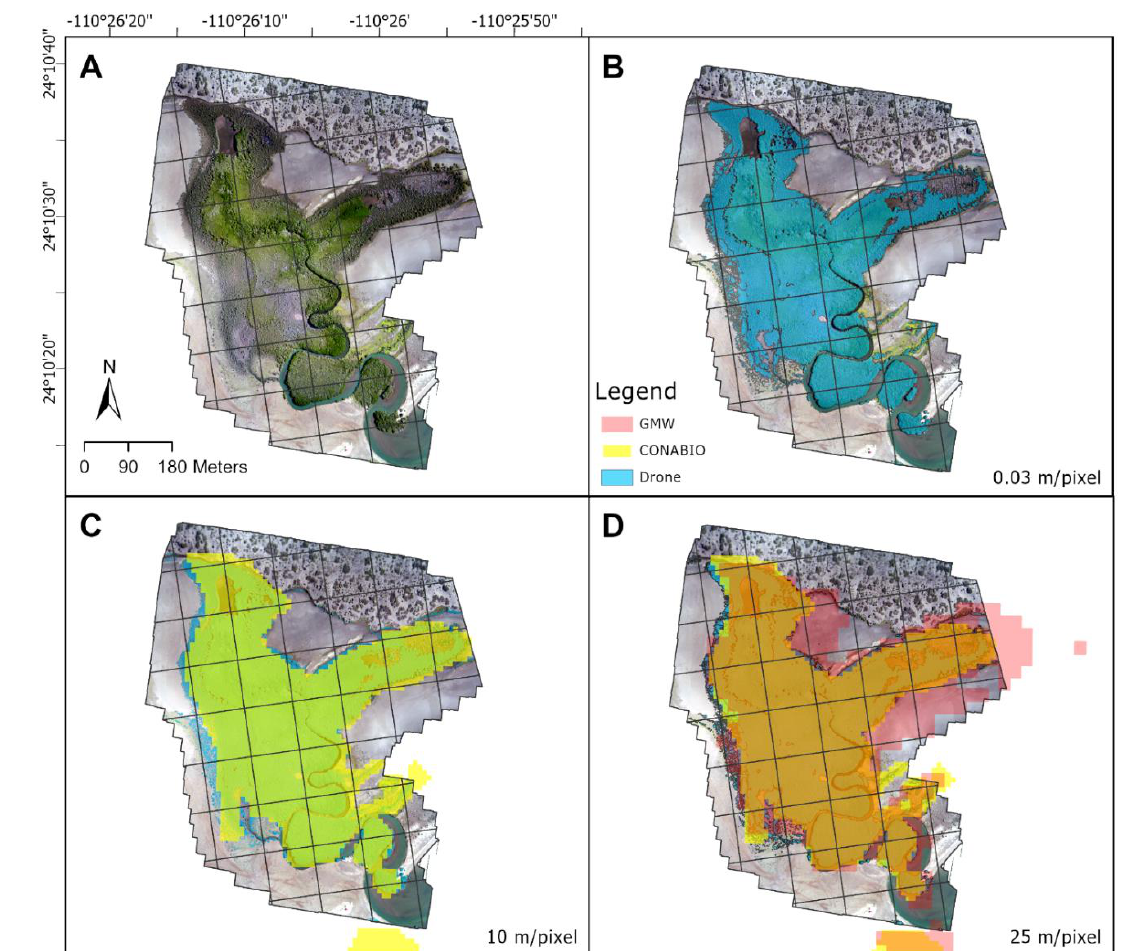
Figure 3. Comparison of mangrove labels divided into one-hectare fishnet cells, and limited by the drone image extent ( A ) in the site Zacatecas in La Paz during July 2018. Labels are generated from ( B ) drones at 3 cm resolution (blue), ( C ) CONABIO 2015 data at 10 m resolution (yellow), and ( D ) GMW 2016 data at 25 m resolution (red). Resolutions of the dataset is noted in the lower right-hand corner. Note that the layer color appears to change due to the transparency of the layer.